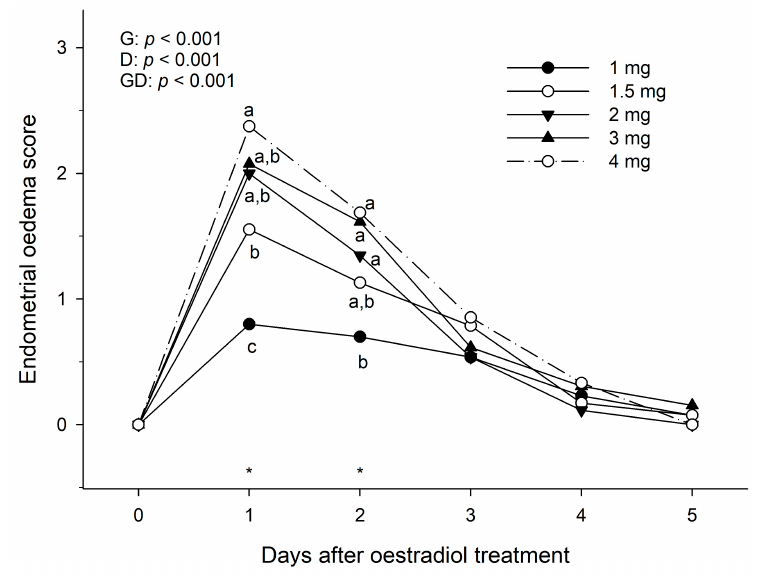
Figure 2. Mean endometrial oedema score in anoestrous mares treated with different dose rates of oestradiol benzoate in a single administration (Day 0). Probabilities for main effects of dose group (G), Day (D), and the group-by-day interaction (GD) are shown. Within a given Day (*), different letters (a, b, c) indicate a significant difference ( p < 0.05) in endometrial oedema score between dose groups.